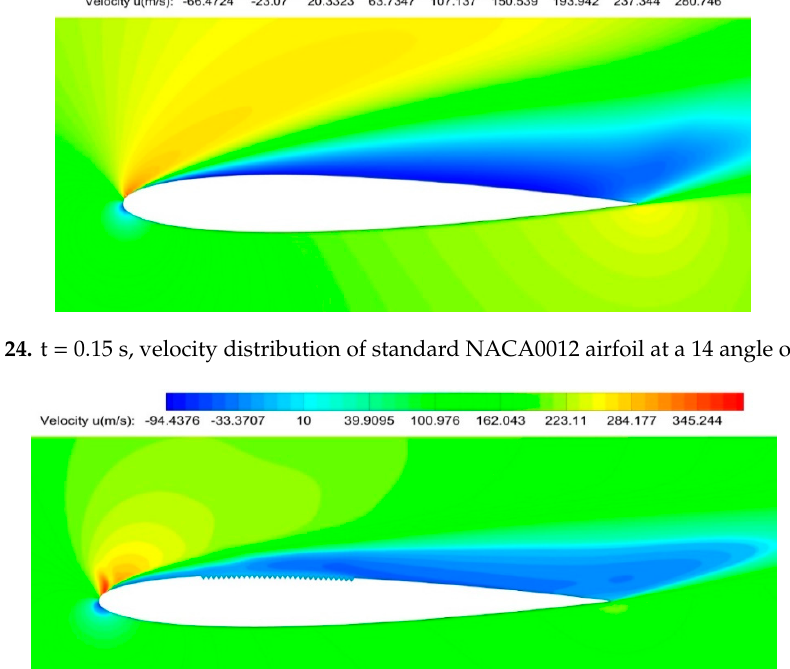
Figure 23. Streamline of NACA0012 airfoil with grooves on the pressure side at a 10 ° angle of attack at different times. ( a ) t = 0.003 s, ( b ) t = 0.005 s, ( c ) t = 0.1 s, ( d ) t = 0.2 s, ( e ) t = 0.3 s, and ( f ) t = 0.4 s.